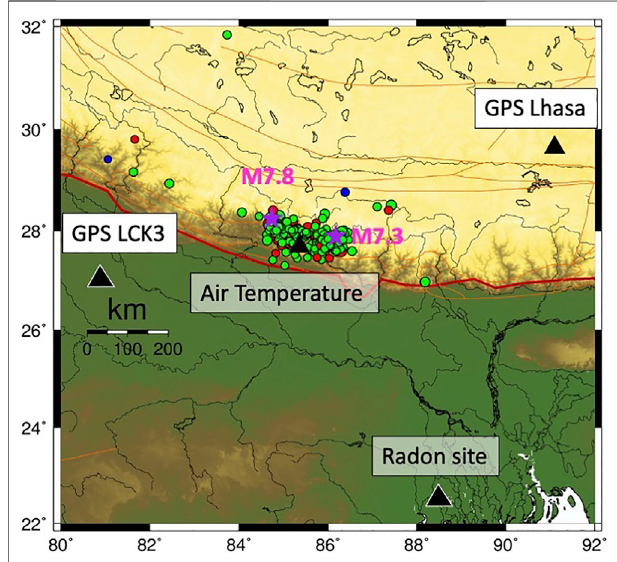
FIGURE 1 | Reference map of Nepal region, with the location of earthquakes > M4 for Jan – May 2015. The location of M7.8 of April 25 and M7.3 of May 12, 2015 are with purple stars. With black triangles are showing the location of the air Temperature station (katmandu) and GPS stations (Lhasa), radon site (Kolkata,